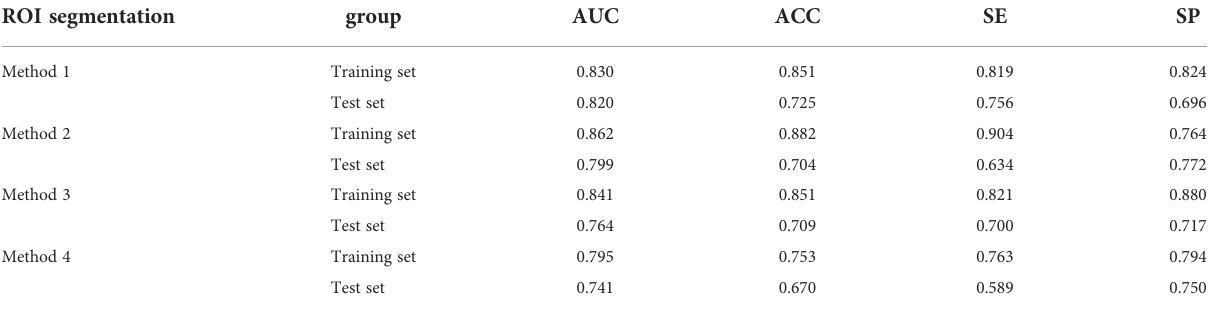
TABLE 4 ROC analysis by LR of the training and test sets.